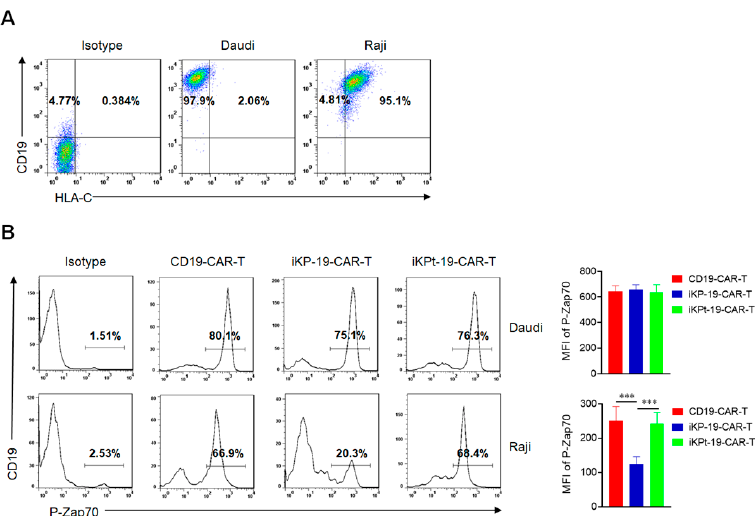
Figure 2. Dephosphorylating P-Zap70 by iKP CAR via intracellular PD-1 domain. ( A ) Flow cytometric analysis of CD19 and HLA-C1 expression in Daudi cells or Raji cells by using APC-anti-human CD19 and PE-anti-human HLA-C antibodies. ( B ) Expression analysis of P-Zap70 in different CAR-T cells by flow cytometry. iKP-19-CAR-T/iKPt-19-CAR-T cells and CD19-CAR-T cells were exposed to Daudi cells or Raji cells for 6 h at a 1:1 ratio in RPMI-1640 medium, stained with PE-anti-human P-Zap70 antibody and MFI of P-Zap70 was statistically analyzed ( n = 4 different donors). All the experiments were conducted in triplicate manner using PBMCs from each donor. *** p < 0.001. Error bars represent ± SD. The CD19 CAR positive rate was unified using UT cells in all the co-culture experiments in this